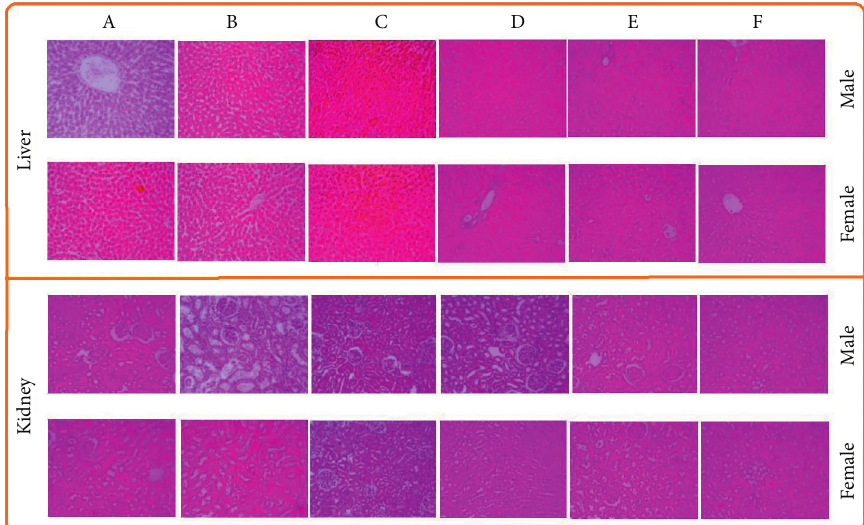
Figure 1: Photomicrographs of the liver and kidney of male and female rats in subacute oral toxicity of AND-2-HyP- β -CYD complex: (a) normal control, (b) low dose (1/10 of LD50 dose, 200mg/kg), (c) medium dose (1/5 of LD50, 400mg/kg), (d) high dose (1/3 of LD50, 666mg/kg), (e) reversal control of high dose (666 mg/kg), and (f) reversal control. Magnification of 40x was used. No observable signs of toxicity are found in any doses and groups.